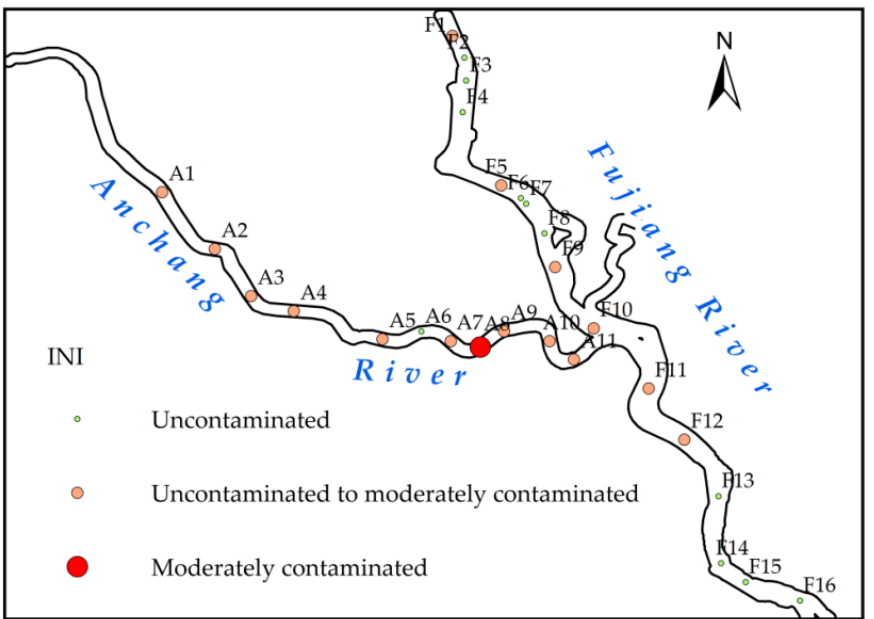
Figure 5. INI degree for HMs in the Mianyang section of the Fujiang River.